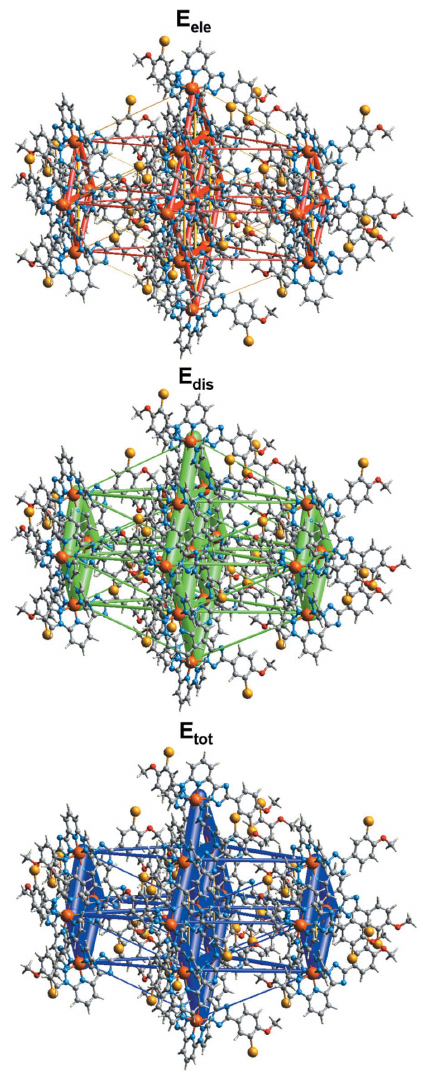
Figure 5 The calculated energy frameworks, showing the electrostatic potential forces ( E ele ), dispersion forces ( E dis ) and total energy ( E tot ) diagrams. Tube size is set at 100 scale, cut-off is 5 kJ mol (cid:3) 1 .